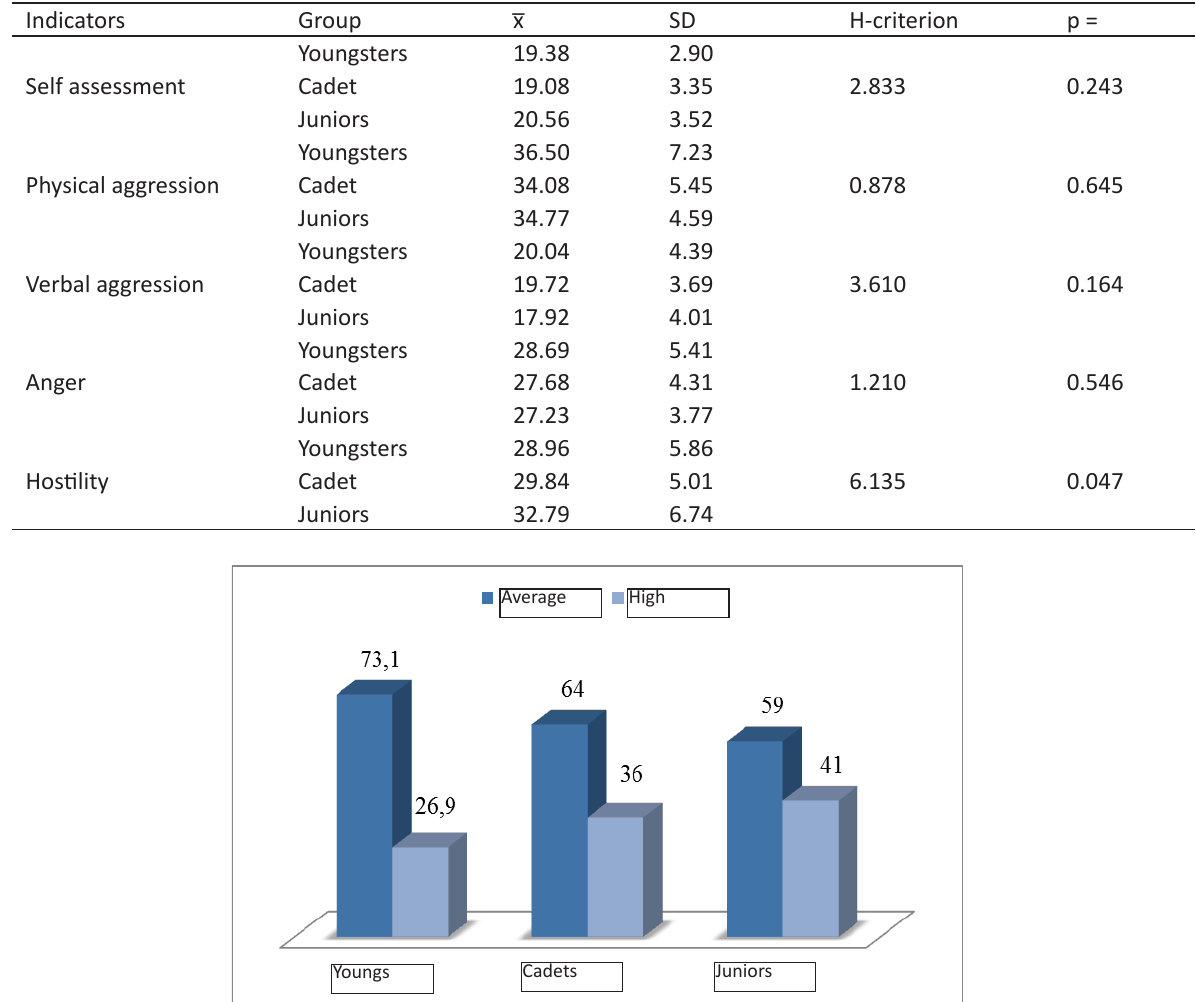
Table 2. Self assessment and aggressiveness indicators in different age groups (points) Indicators